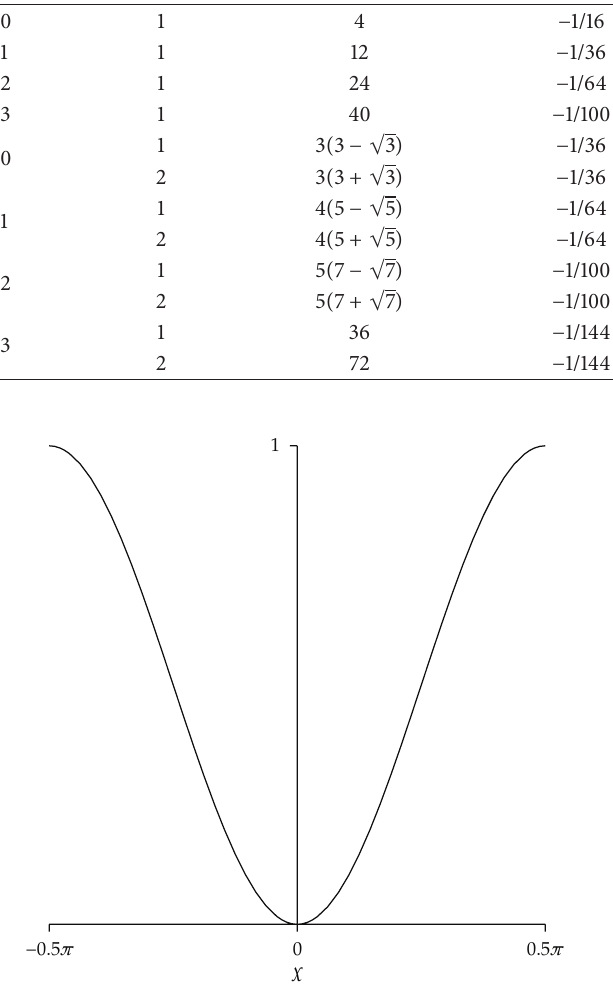
Figure 3: Graph of the sine-squared potential for 𝑉 0 = 1